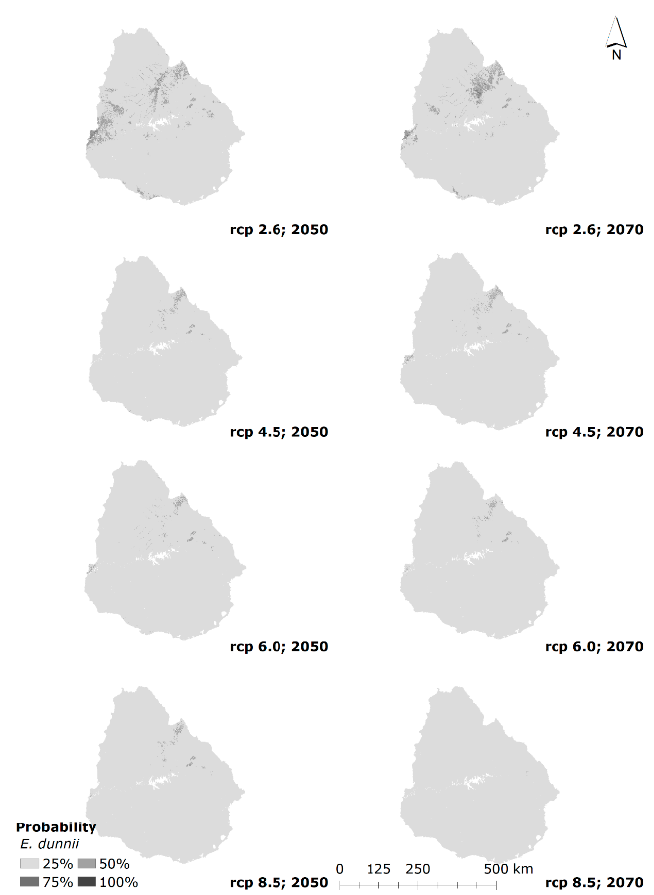
Figure 5. Future probability of occurrence of E. dunnii obtained with the ensemble model global circulation CCSM4, in the scenarios RCP 2.6, 4.5, 6.0, and 8.5, for the years 2050 and 2070.